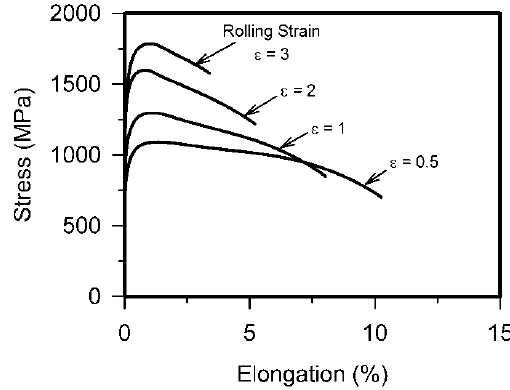
Figure 6. Engineering stress vs. plastic elongation curves for a 304L stainless steel subjected to cold